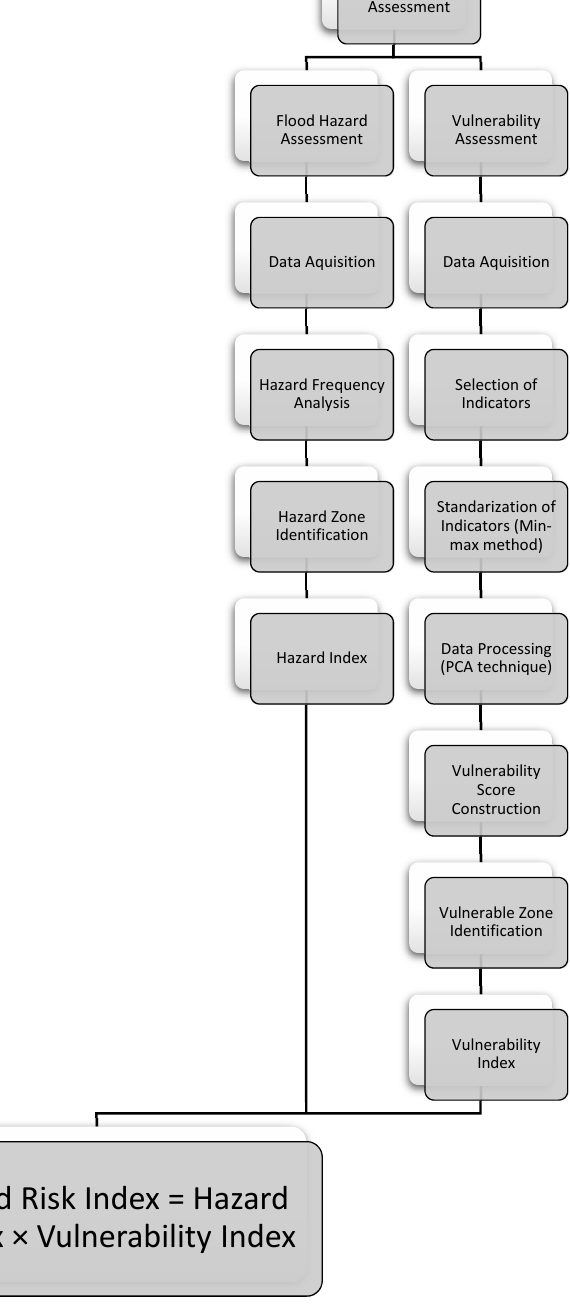
Figure 4. Conceptual framework of adopted research design for flood risk assessment in the study area.